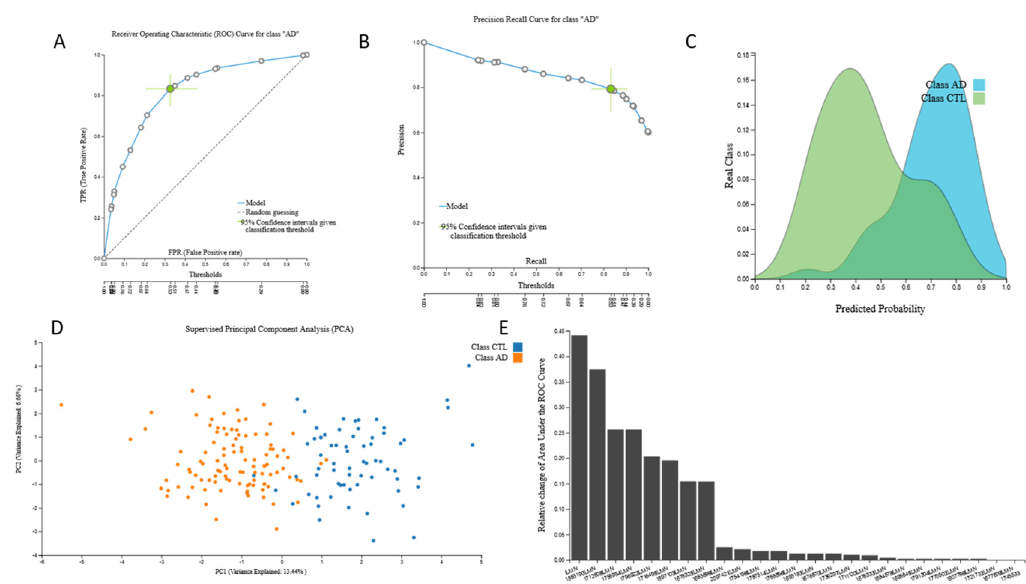
Figure 4. The 38,327-feature mRNA-transcriptomic sub-dataset (train) signature performance, selected predictors and model inspection: ( A ). Receiver Operating Characteristic (ROC) Curve for AD class, ( B ). Precision-recall plot, ( C ). Probabilities density plot, ( D ). Supervised Principal Component Analysis plot depicting discrimination between AD patients and age–sex matched cognitively healthy individuals, ( E ). Cumulative feature importance plot of the 25 mRNA predictors of the signature.